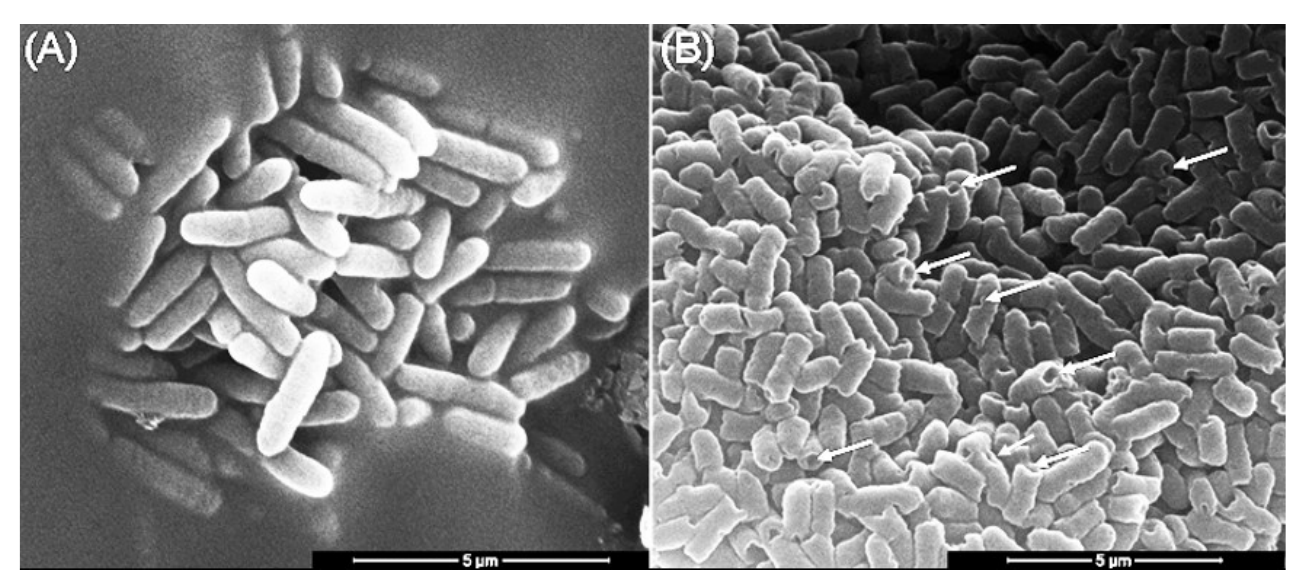
Figure 4. The effects of mastoparan-AF on hemolytic E. coli O157:H7 investigated by SEM. ( A ) Untreated hemolytic E. coli O157:H7. ( B ) Hemolytic E. coli O157:H7 were treated with mastoparan-AF at 2 × MIC (32 μg mL −1 ) for 1 h. Abnormal dents and large perforations (full opening) at apical ends (indicated by arrows) appeared on the surface of bacteria.